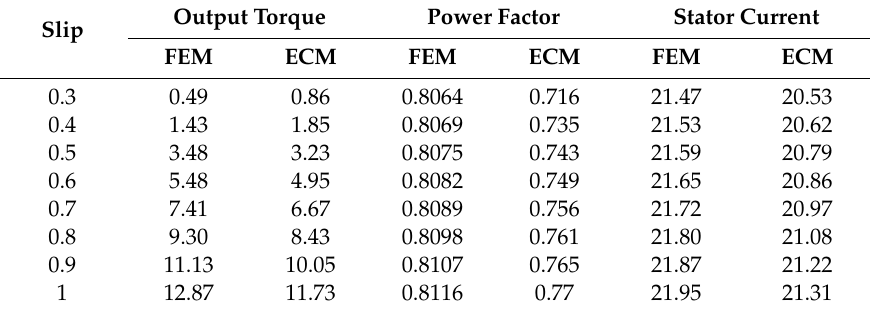
Table 5. Output torque, power factor, and stator current against slip.